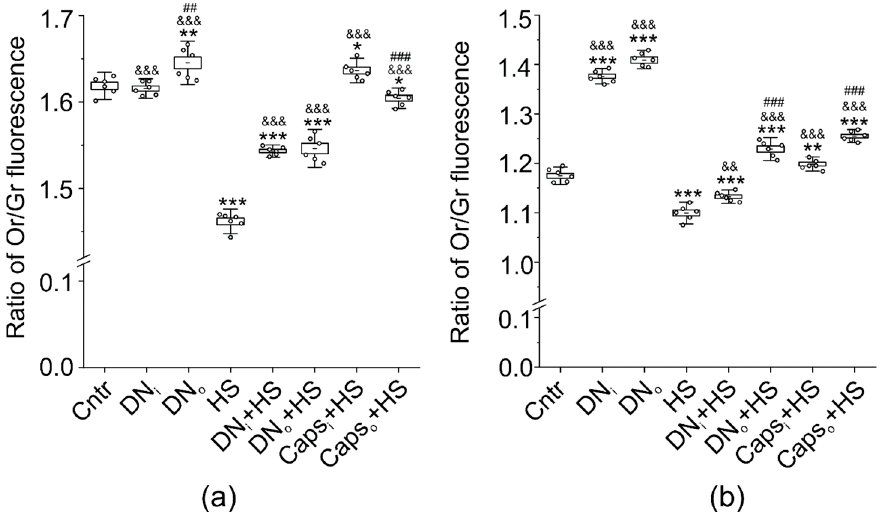
Figure 6. Effects on fluorescence of membrane asymmetry and ordering-sensitive dye F2N12S. ( a , b ) The ratio of Or/Gr fluorescence of ratiometric fluorescent probe F2N12S is shown. Junctional ( a ) and extrajunctional membrane ( b ) were labeled with F2N12S in control (Cntr), suspended muscle (HS), after unilateral denervation in intact (DN i ) and operated (DN o ) muscle, after unilateral denervation following HS in intact (DN i +HS) and operated (DN o +HS) muscle, after unilateral application of Caps to the sciatic nerve in intact (Caps i +HS) and operated (Caps o +HS) muscle. N = 6 animals for each group. * p <0.05, ** p < 0.01, *** p < 0.001—differences compared control (Cntr); && p < 0.01, &&& p < 0.001—differences compared to HS; ## p < 0.01, ### p < 0.001—differences between intact and operated limb. p was evaluated by a Mann–Whitney U